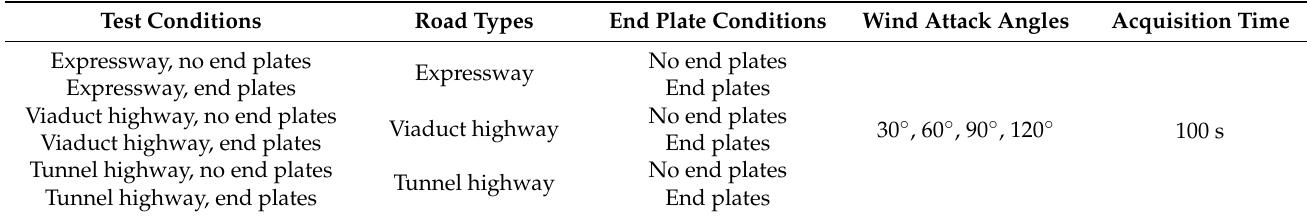
Table 2. Description of the transiting test